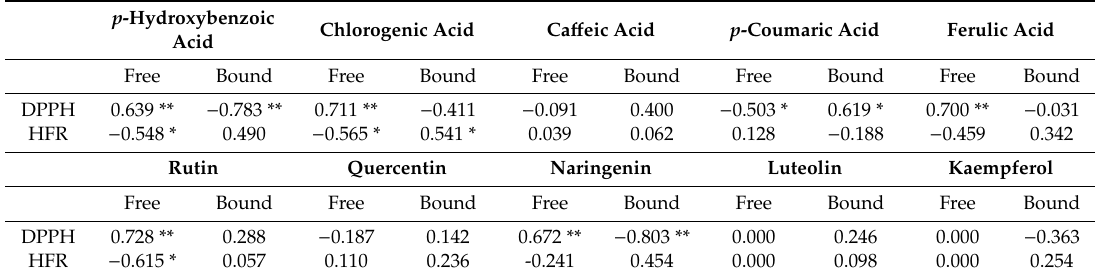
Table 3. Pearson’s correlation coe ffi cients of phenolic compounds and antioxidant capacities. p -Hydroxybenzoic Acid